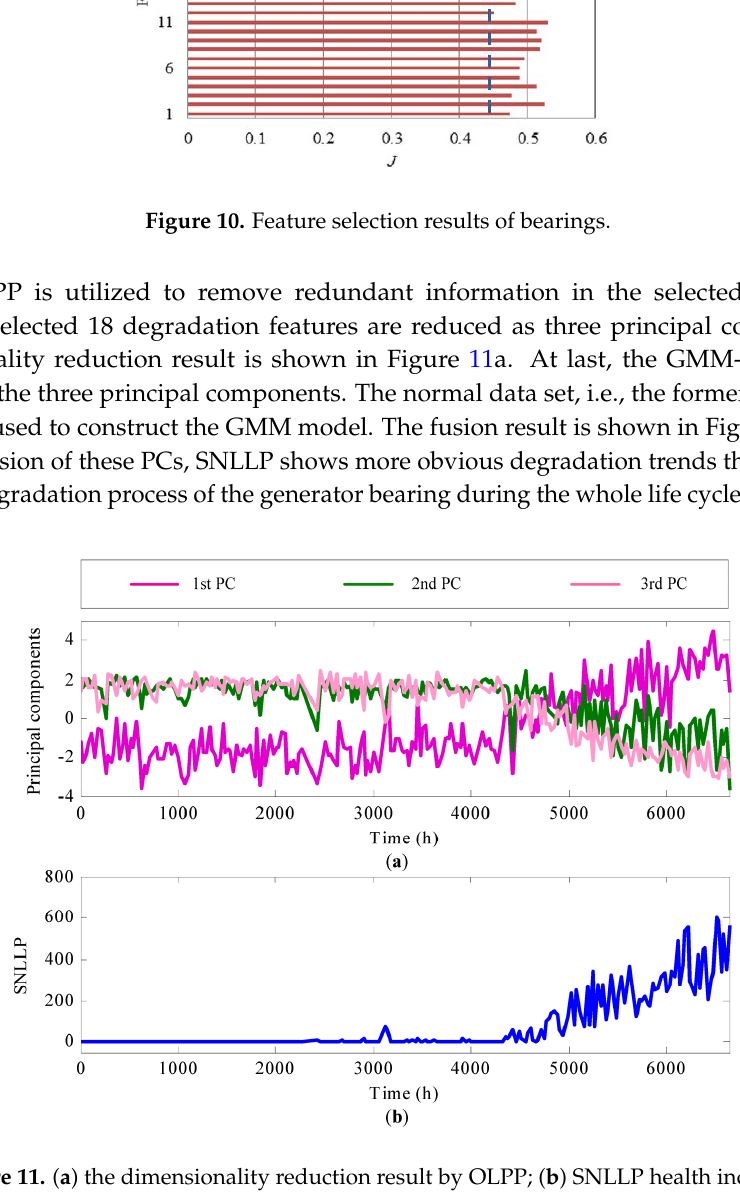
Figure 10. Feature selection results of bearings.